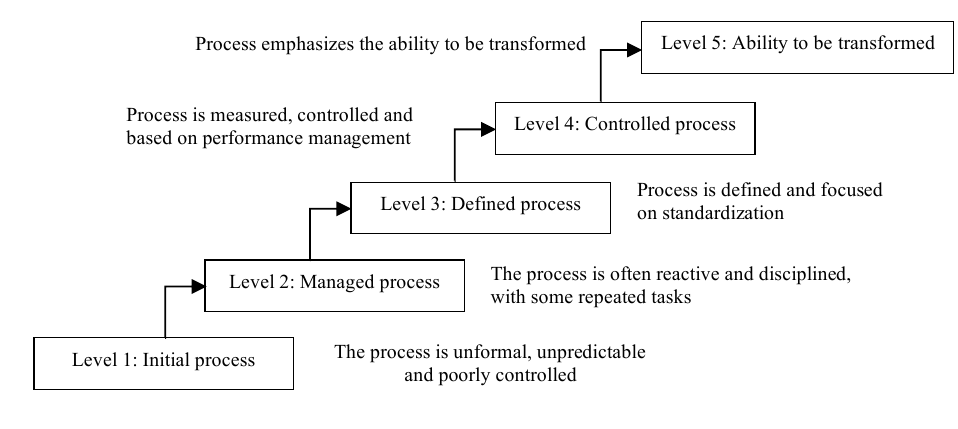
Fig. 1. maturity levels industrial performance